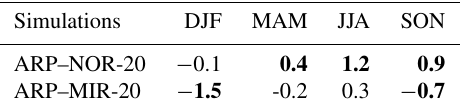
Table 3. Mean seasonal T 2m differences (in kelvin) for the grounded AIS with respect to the ARP-AMIP simulation. Differ- ences significant at p = 0 . 05 are presented in